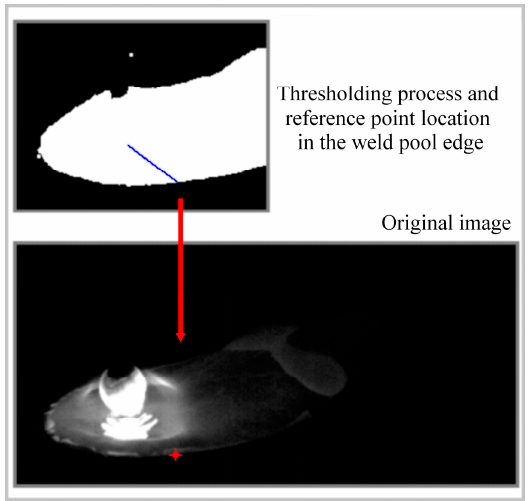
Figure 7. Reference point located in the weld pool edge to measure the weld bead width [22].